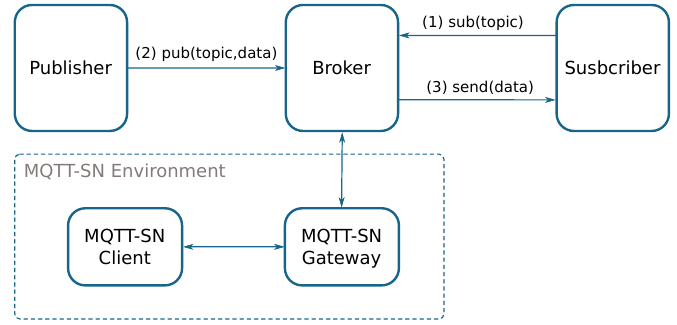
Figure 4. Basic MQTT (Message Queue Telemetry Transport)